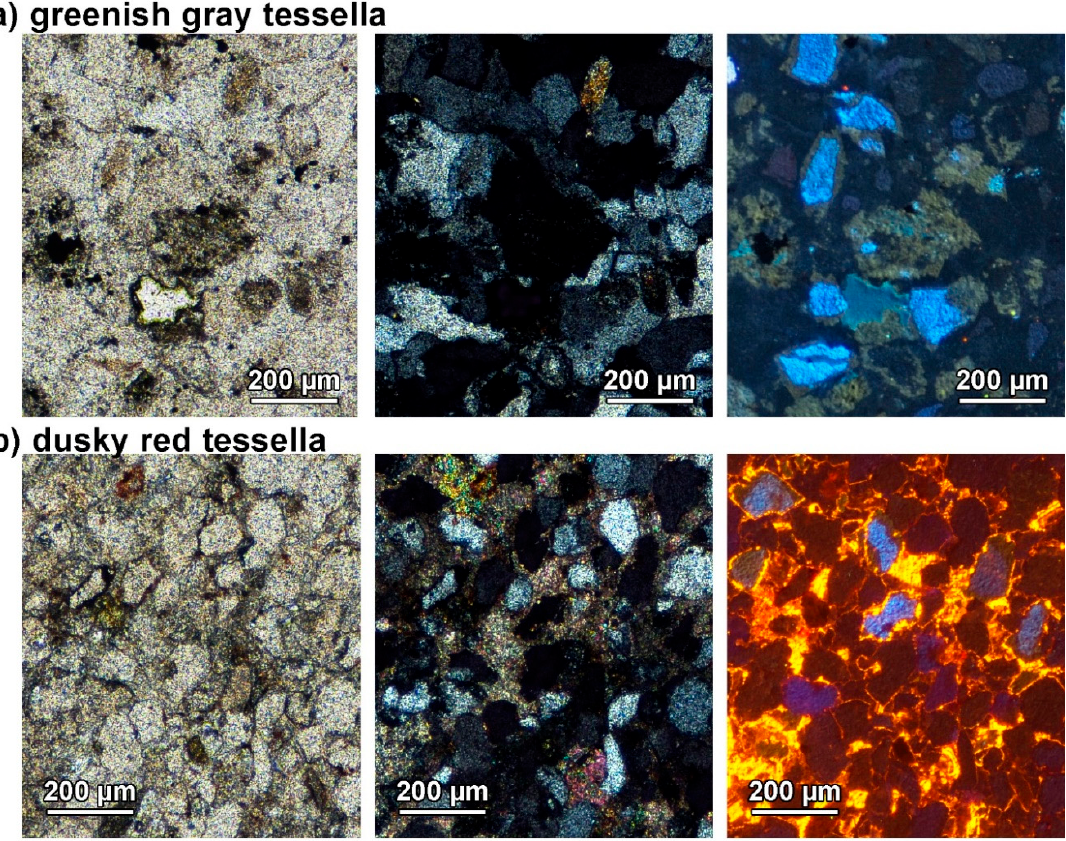
Figure 13. Petrographic images of the sampled sandstone tesserae from the mosaic MAC-19004 including PPL (left), XPL (middle), and CL (right) micrographs of the same areas ( a ) sampled greenish gray tessella exhibiting typical features of Montjuïc sandstone (K-feldspar and quartz clasts with authigenic overgrowths). ( b ) Sampled dusky red tessella exhibiting K-feldspar and quartz clasts with authigenic overgrowths embedded in a carbonatic cement (orange in CL mode).